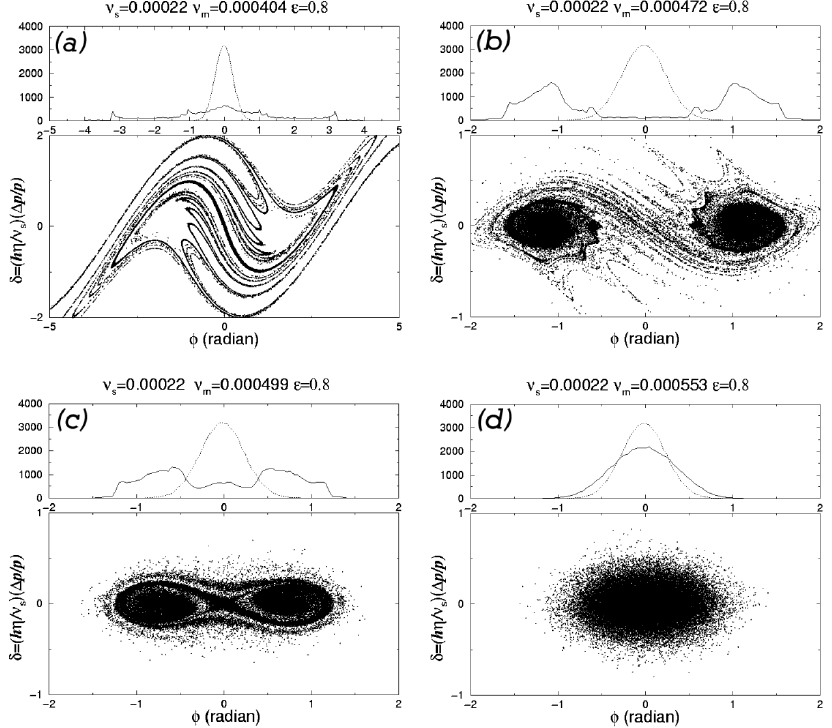
FIG. 4. Tracking simulations starting with 50 000 particles in a Gaussian distribution and using the same parameters as in Fig. 3. In all cases the parameter e is ramped from 0 to 0.8 in ten synchrotron